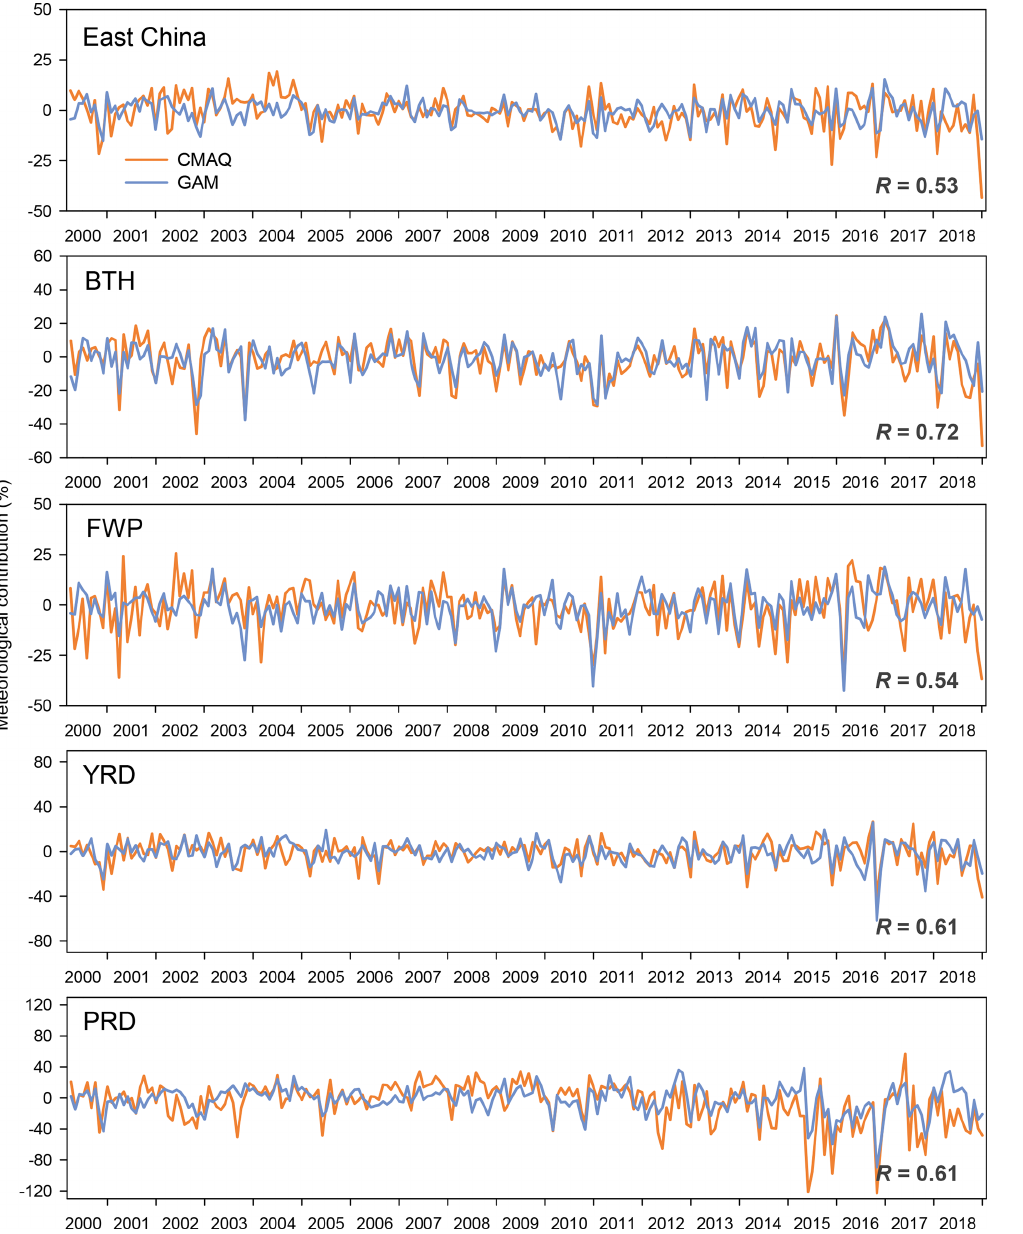
Figure 4. Fractional contribution of meteorology to PM 2 . 5 concentrations on the monthly scale during 2000–2018, estimated from CMAQ (the orange line) and GAM (the blue